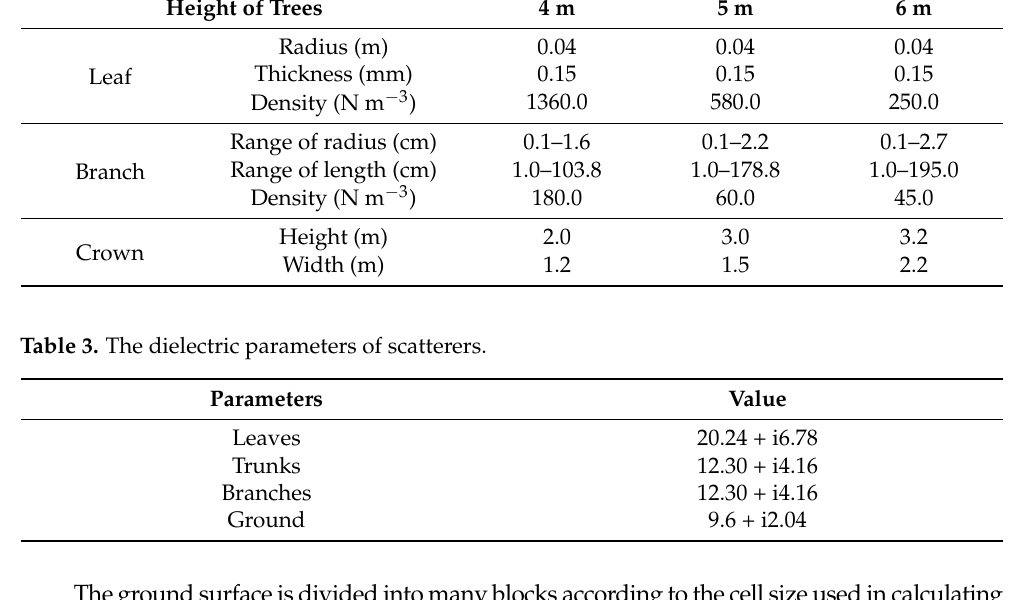
Table 2. Structure parameters of trees.